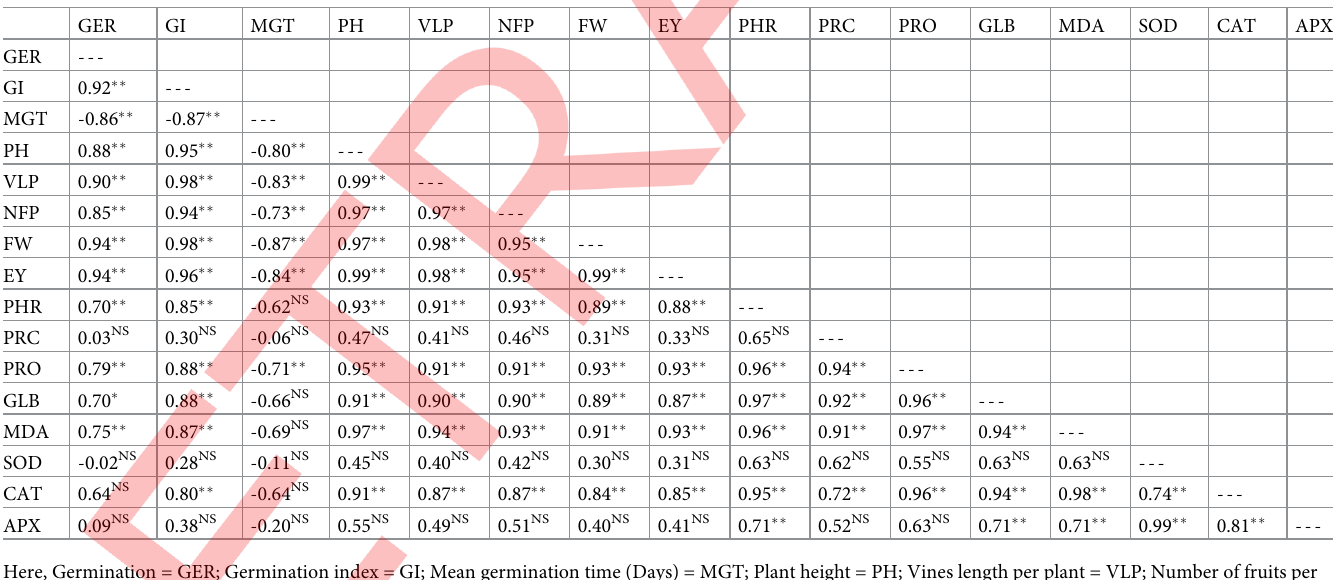
Table 5. Pearson ´s correlation among different growth, yield and biochemical attributes of Indian squash during